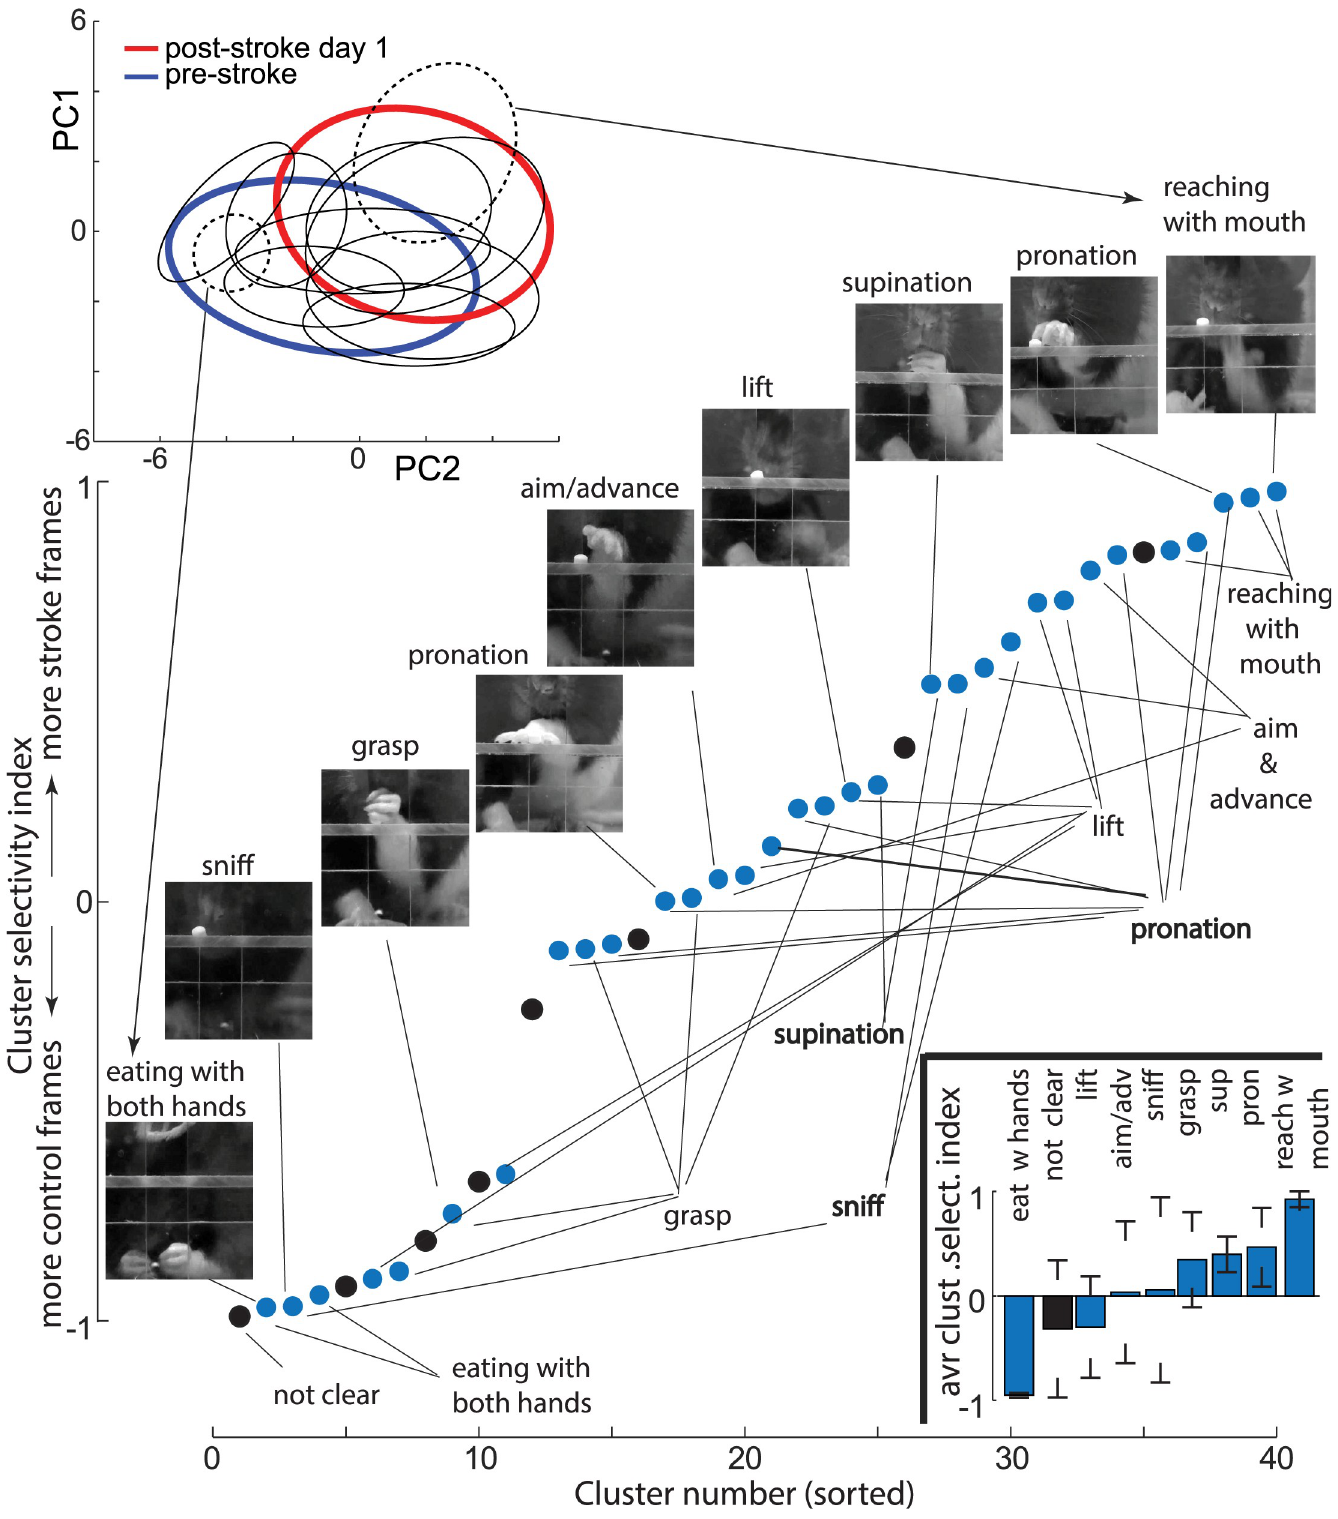
Fig 5. The clustering of the network feature space revealed movement elements specific only to the stroke or the control condition. (Top insert) Blue and red ellipses outline the distribution of points in feature space of the network before and after the stroke, respectively (the same as in Fig 4A). Black ellipses outline subclusters corresponding to individual movement subcomponents. For visualization clarity, only 10 subclusters out of 40 are shown. Dashed ellipses indicate clusters